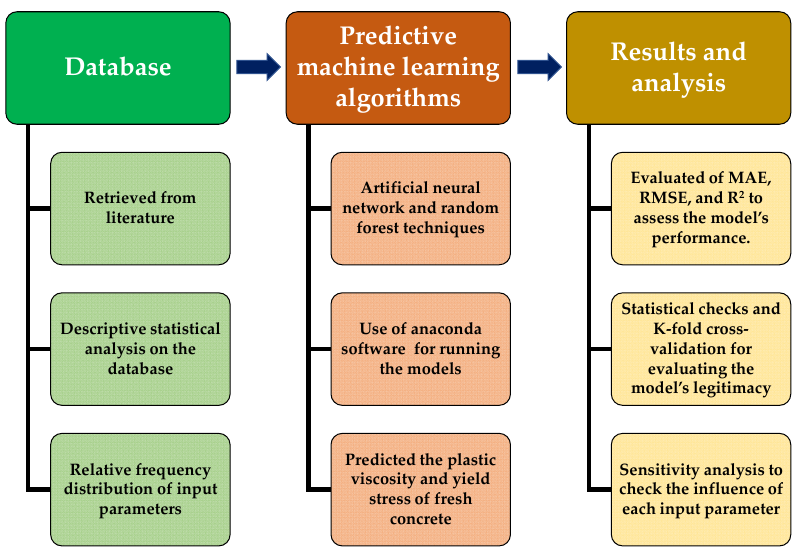
Figure 2. Schematic representation of research’s adopted methodology.